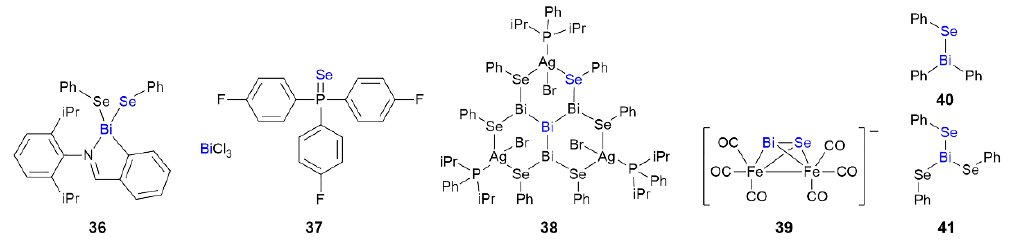
Figure 10. Chemical diagrams for bismuth compounds 36 – 41 .